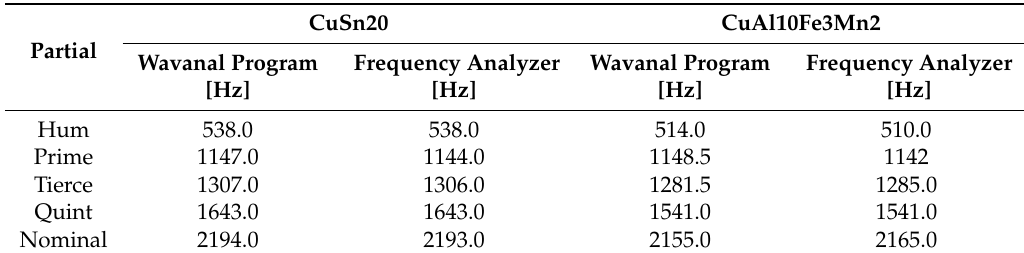
Table 5. Experimental partial frequencies.